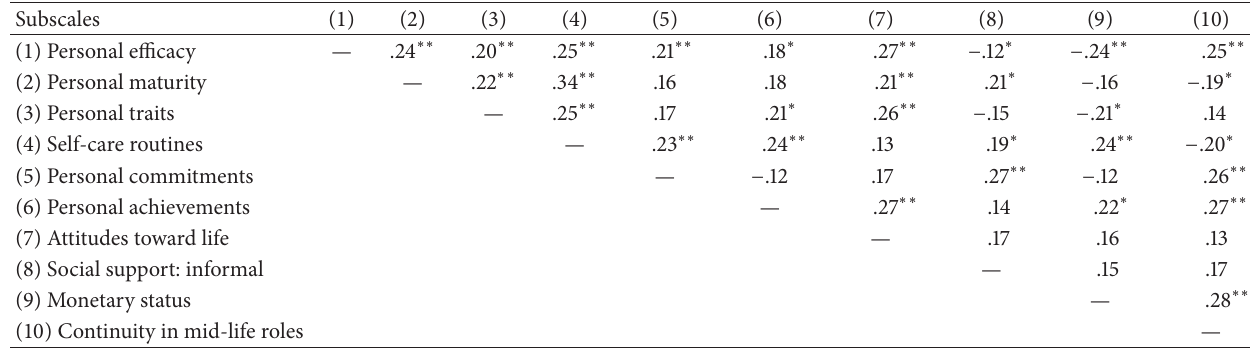
Table 2: Intercorrelations between subscale factors of the SLSAS ( 𝑁 = 430 ).